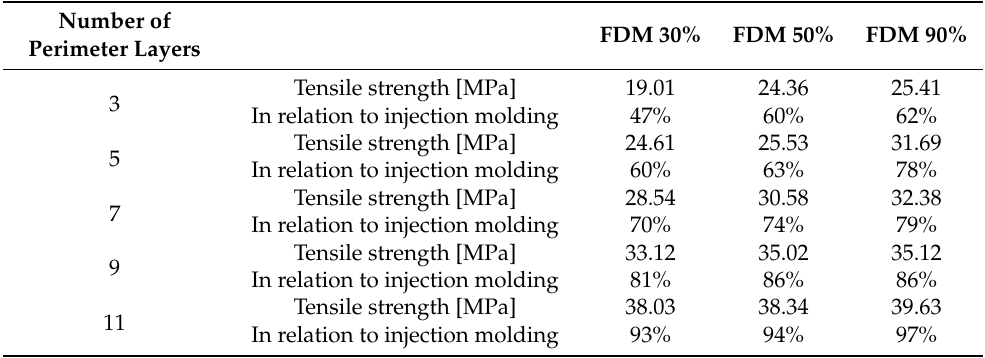
Table 4. Results of the mechanical tests of the samples printed with different numbers of perimeter layers and different infill